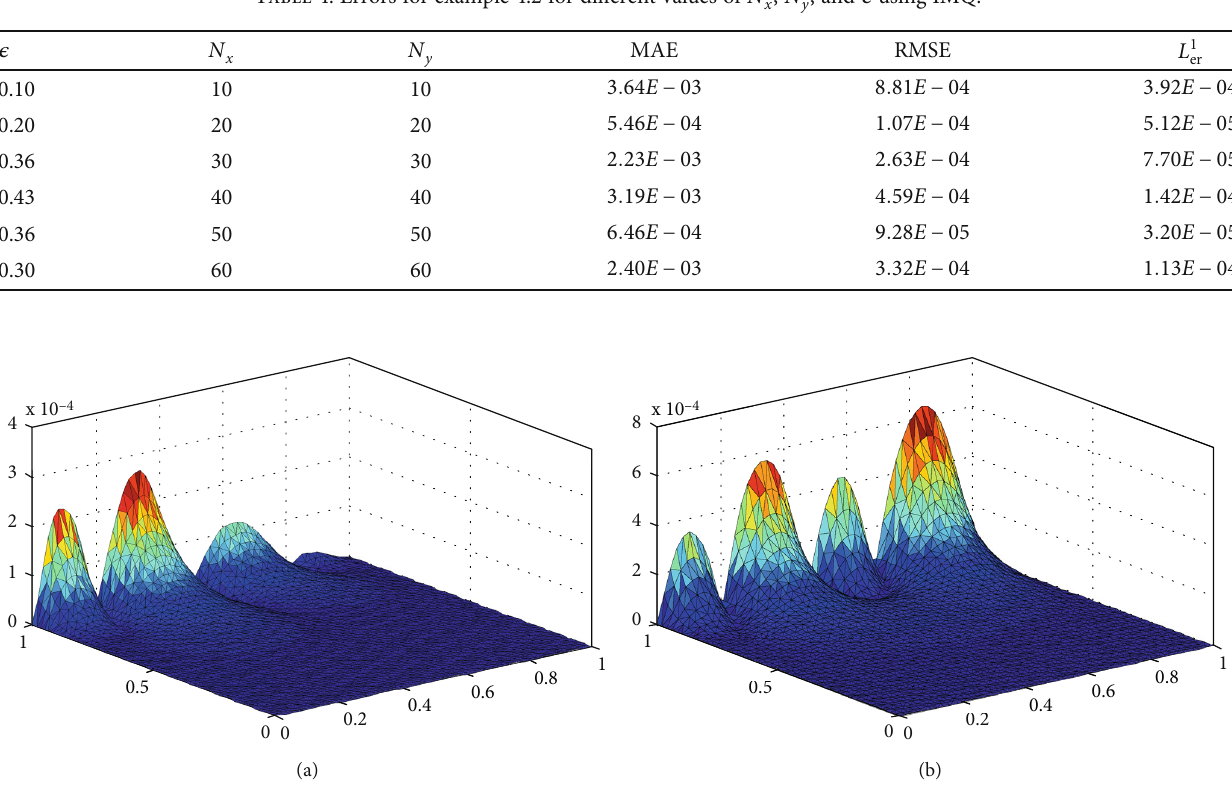
Table 4: Errors for example 4.2 for di ff erent values of N